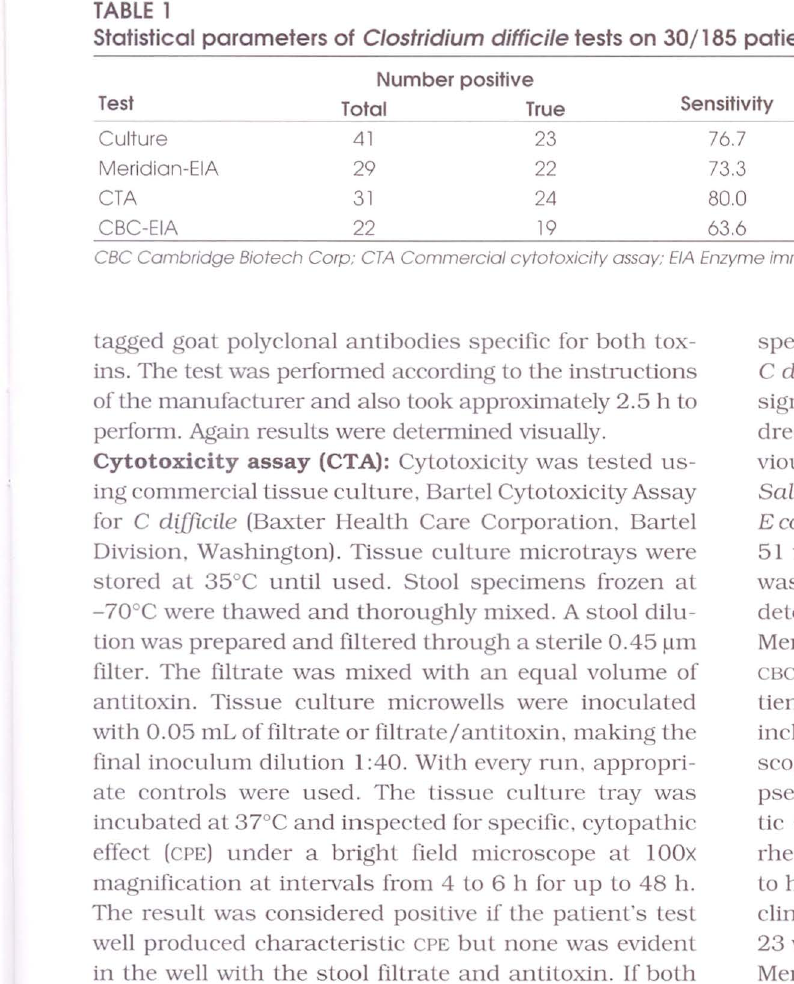
Statistical parameters of Clostridium difficile tests on 30/185 patients with C difficile-associated